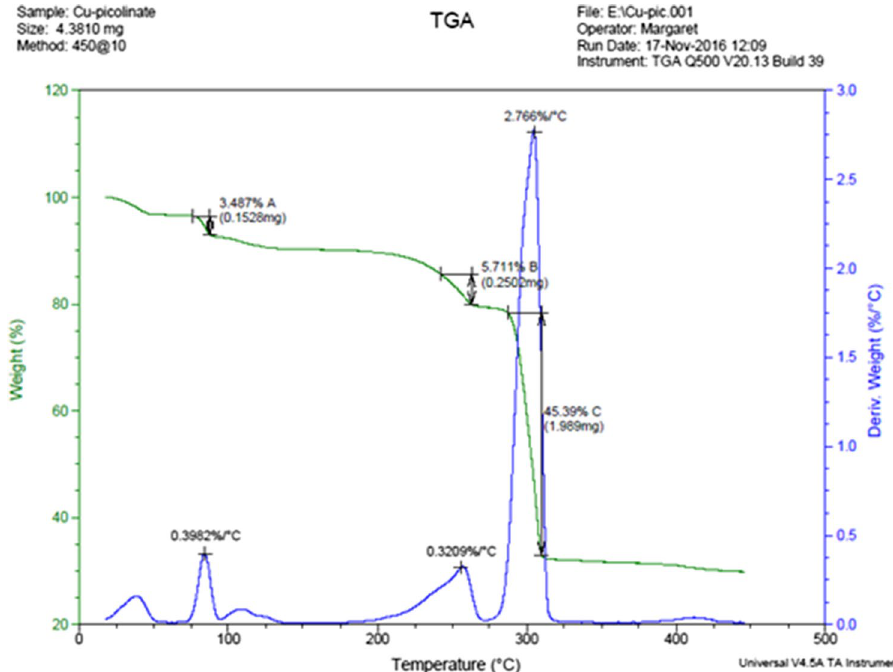
Fig. 5 TGA curve versus tem- perature gradient of